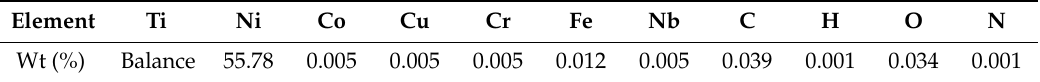
Table 1. Chemical composition of nitinol shape memory alloy